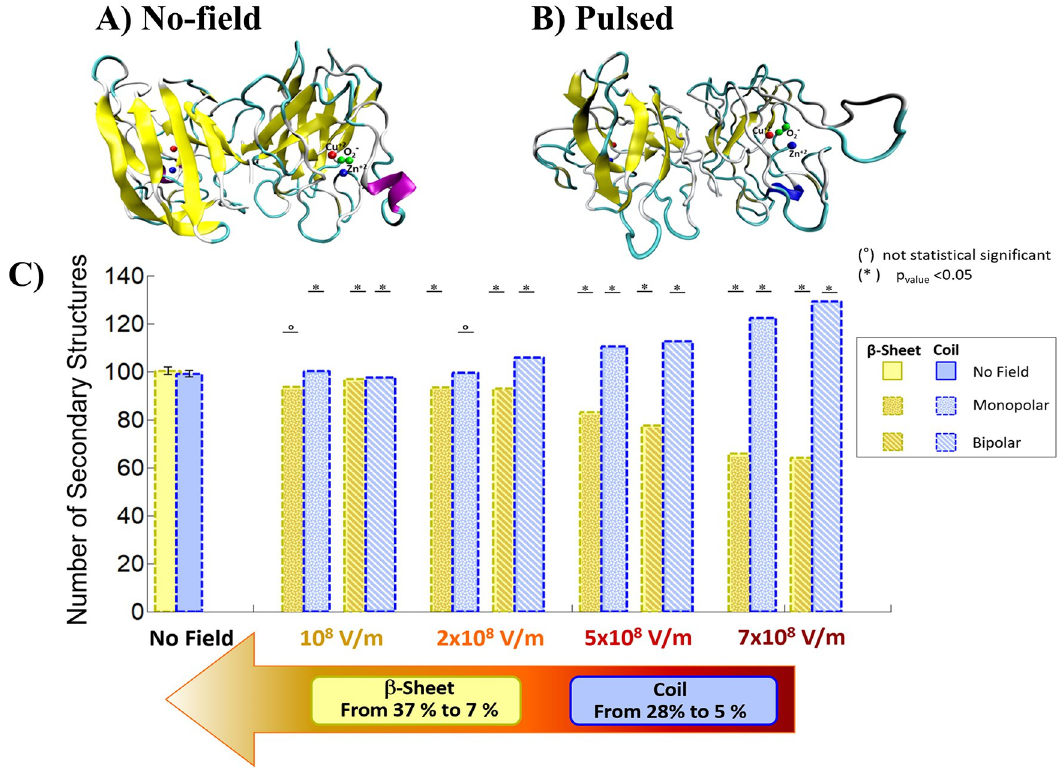
Fig 3. SOD1 secondary structures analysis. Panel A and B. Comparison of the conformation of SOD1 before exposure (A) and after an exposure to a Bipolar pulse with 7x10 8 V/m intensity (B). Panel C. Coil and β -Sheet secondary structures mean values. The results are presented in no exposure condition and under MP and BP 100 nsPEF with intensities ranging from 10 8 to 7x10 8 V/m. The asterisk ( � ) indicates p value smaller than 0.05 (p < 0.05) which means a variation statistically significant, and the circle (˚) indicates no significant differences. The statistical analysis has been performed with the Student t test. Bars on graph indicate the standard